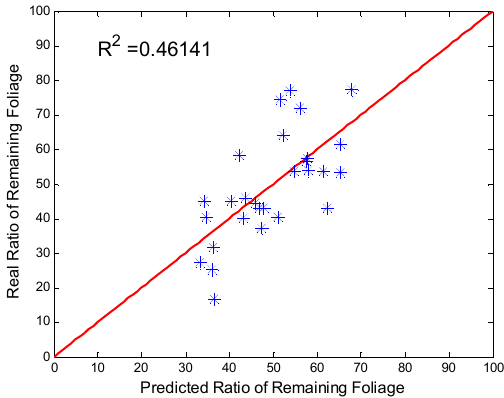
Figure 7. Predicted and real values of average foliage remaining ratios for 28 years.